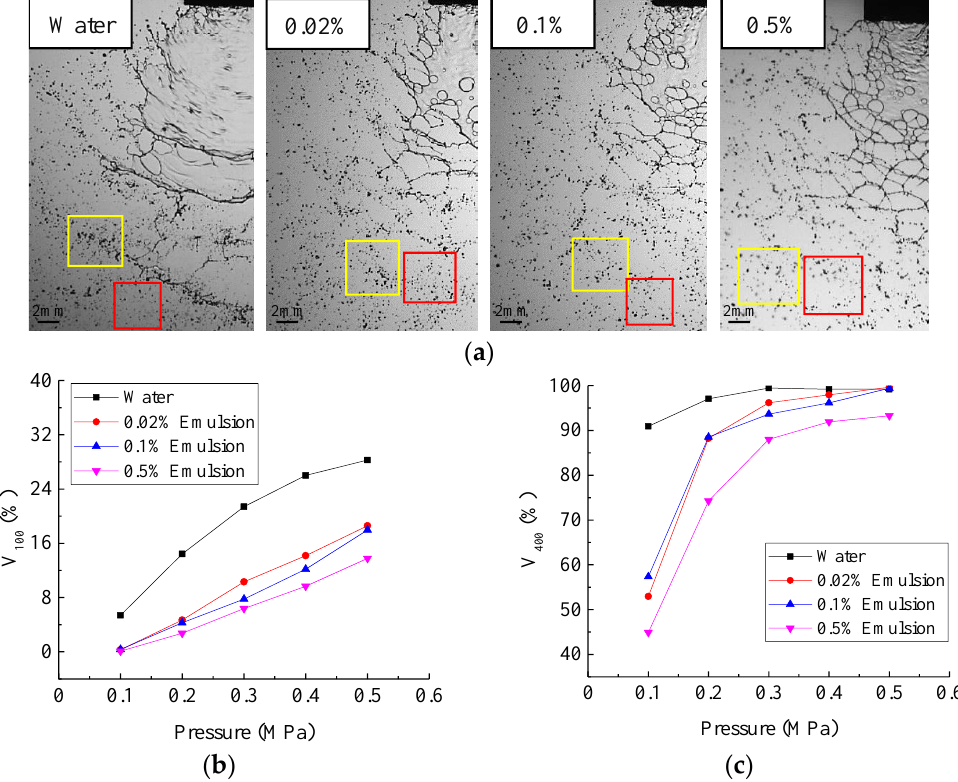
Figure 10. ( a ) Comparison of coarse droplets and fine droplets formed by atomisation of water and different concentrations of emulsion, in which coarse droplets are marked by yellow frames and fine droplets by red frames. ( b ) The effect of emulsion spray on droplet size proportion of V 100 under different pressures. ( c ) The effect of emulsion spray on droplet size proportion of V 400 under different pressures.